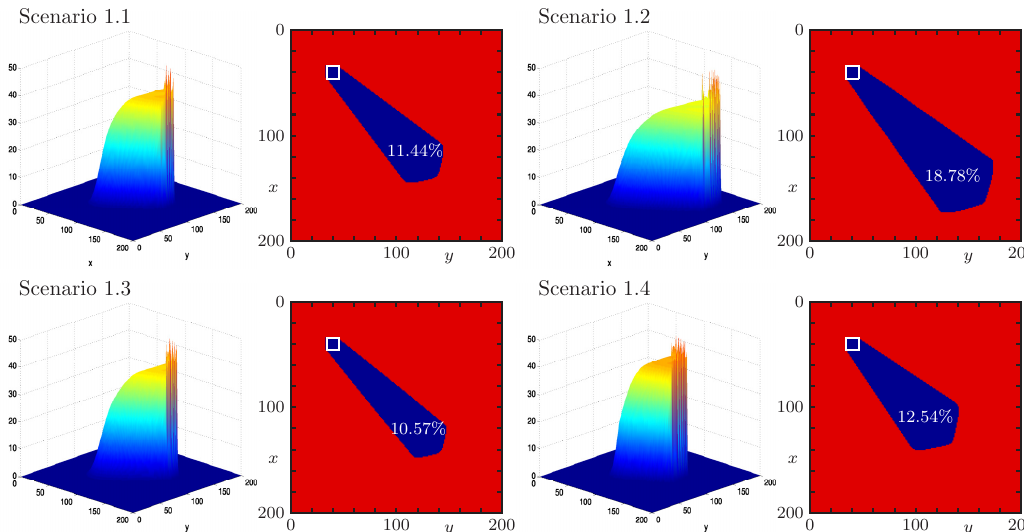
Figure 2. Scenarios 1.1 to 1.4: three-dimensional plots of simulated temperature and two-dimensional plots of simulated burnt fuel, at simulated time T = 12. The red and blue parts correspond to areas with v 0 = 0.9 and v 0 = 0, respectively. The small white square indicates the location of the initial fire focus. The percentages represent the portion of burnt fuel of the total fuel initially available in Ω